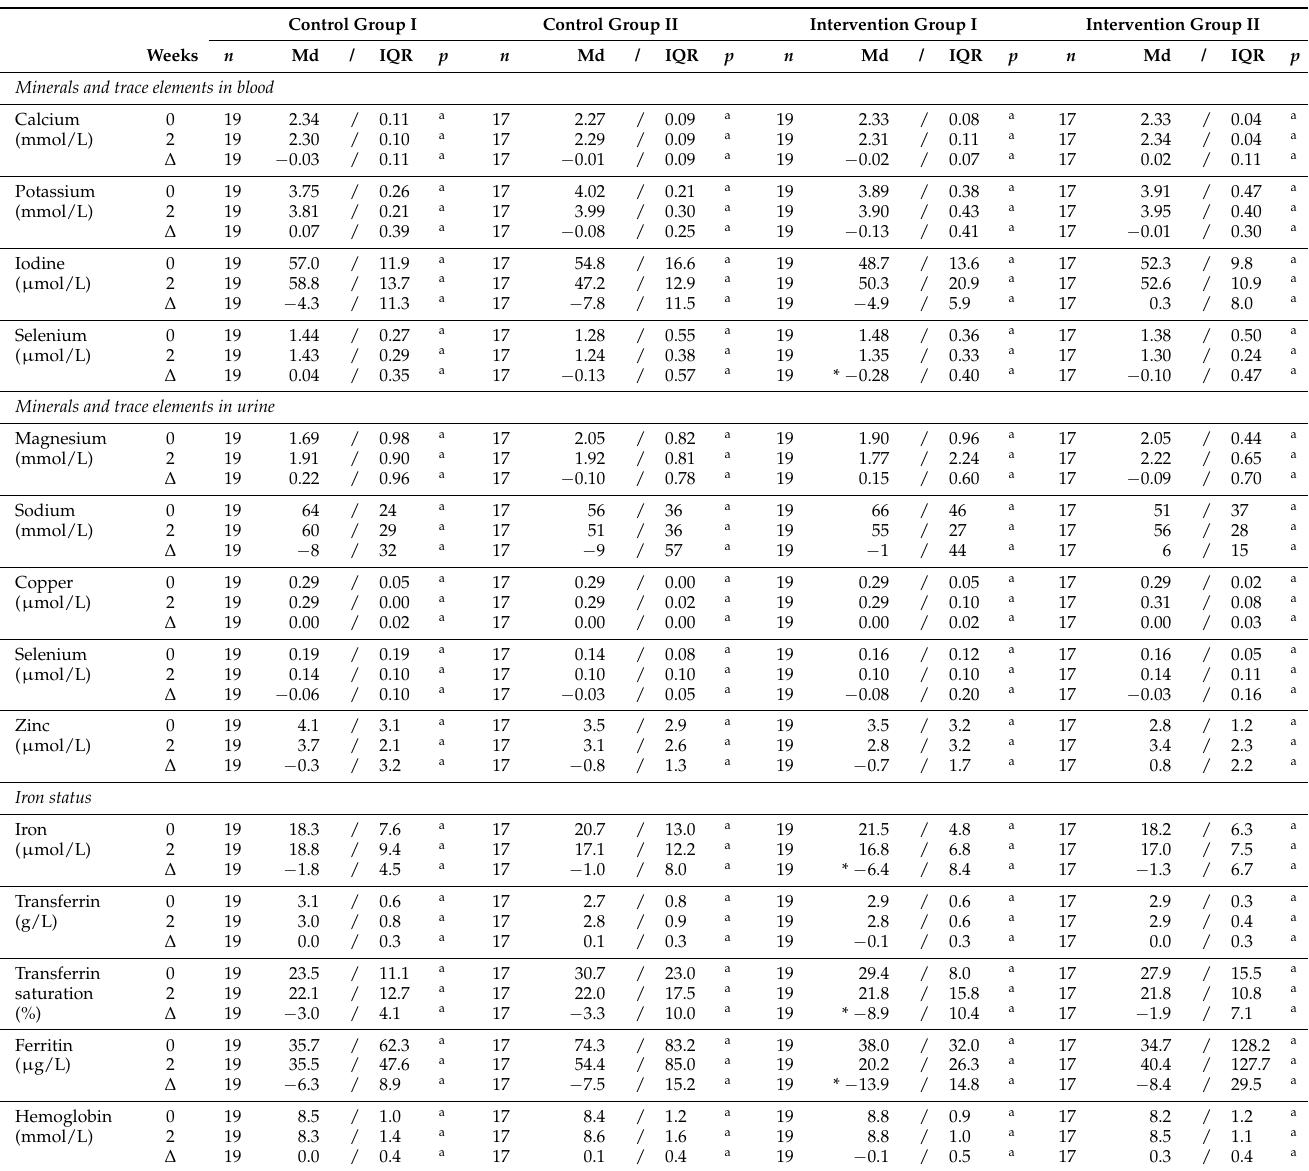
group II = defined background diet + Microchloropsis salina smoothie. ∆ , difference between baseline and end of two-week period. ab Different superscript letters indicate significant differences between the groups ( p < 0.05). * Significant differences between baseline and after the two-week study period within the study group ( p <